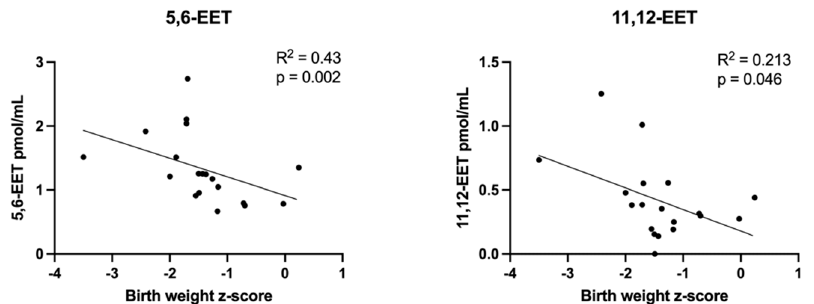
Figure 6. Correlations between umbilical vein plasma lipid concentrations and birth weight z–score : eicosanoids . Scatterplots demonstrate the correlation relationships between birth weight z-score and plasma eicosanoid epoxyeicosatrienoic (EET) acid molecules. Spearman’s rank correlation was computed to assess relationships.